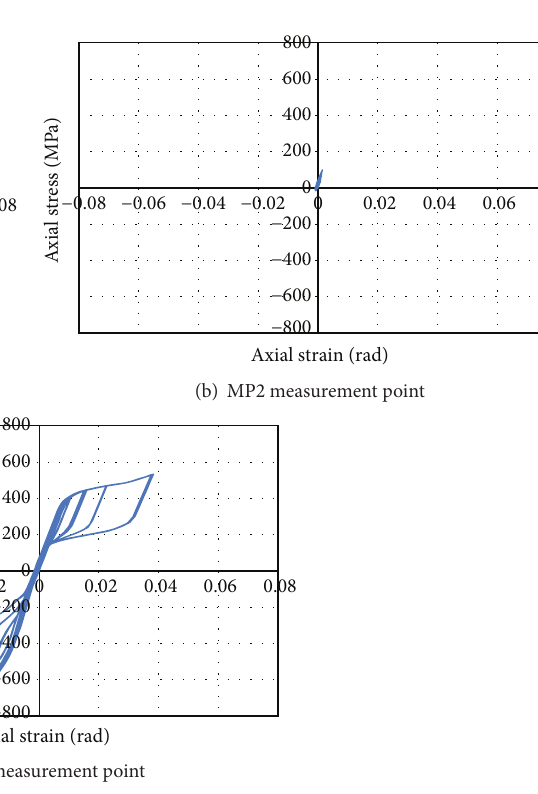
Figure 19: True stress and strain curves obtained from individual measurement points (SMA-0.10